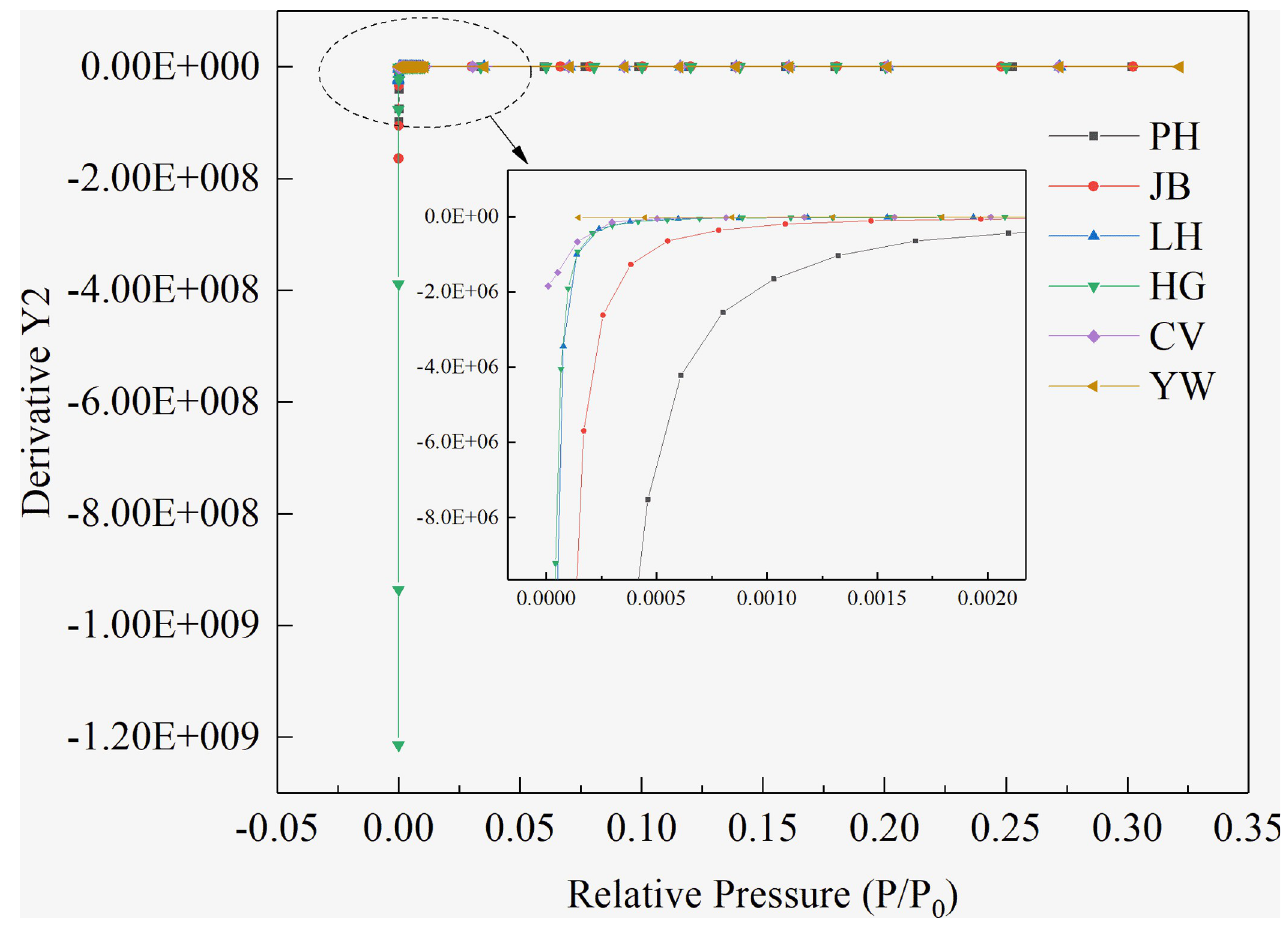
Fig 3. Curvature curves of the adsorption isotherms of coal samples of different coal ranks.